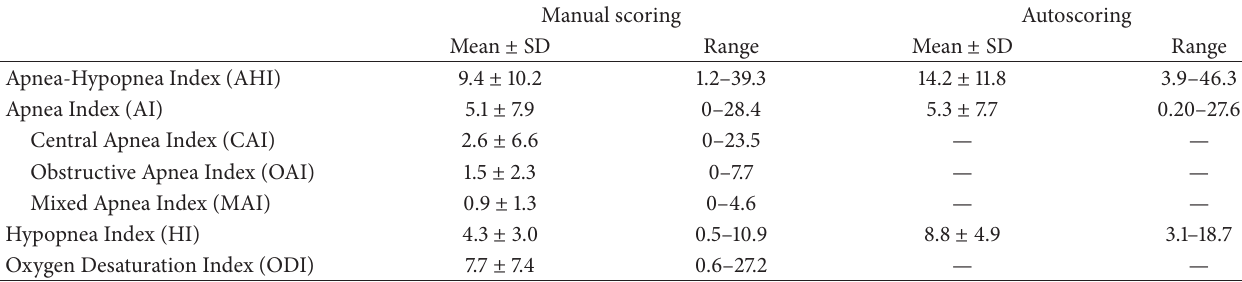
Table 2: OSA variables measured on efficacy